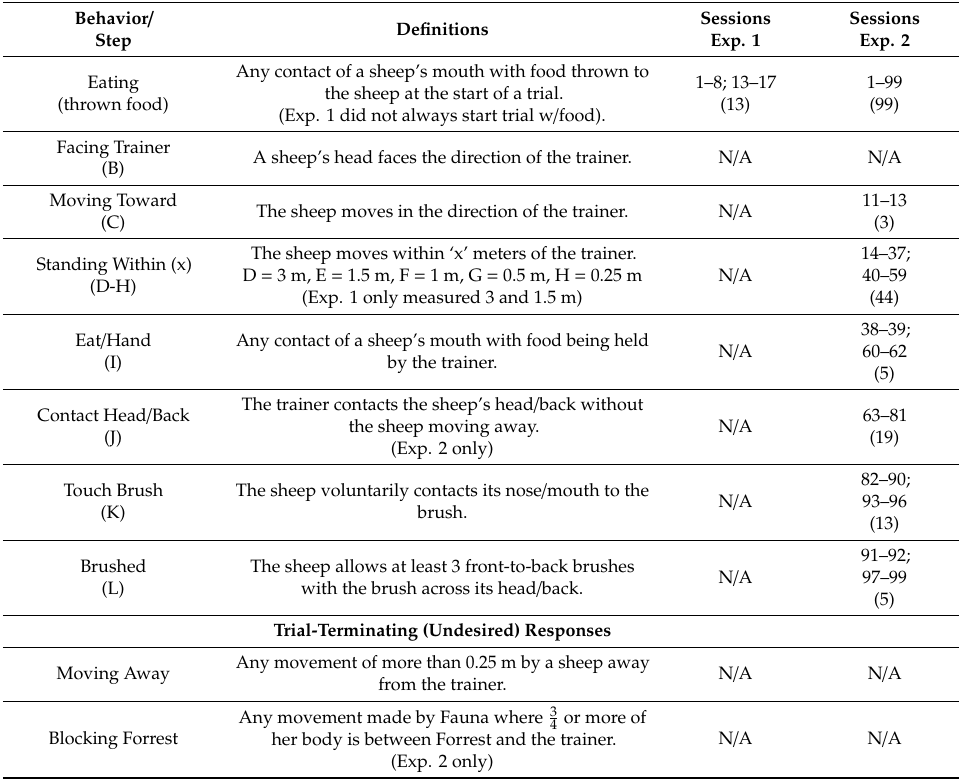
Table 1. Behaviors, definitions, and sessions for the study. The total number of sessions the trial-starting food (e.g., “Eating”) was active (Experiment 1 and 2), as well as the approximation / step intervened upon (Experiment 2) are listed in